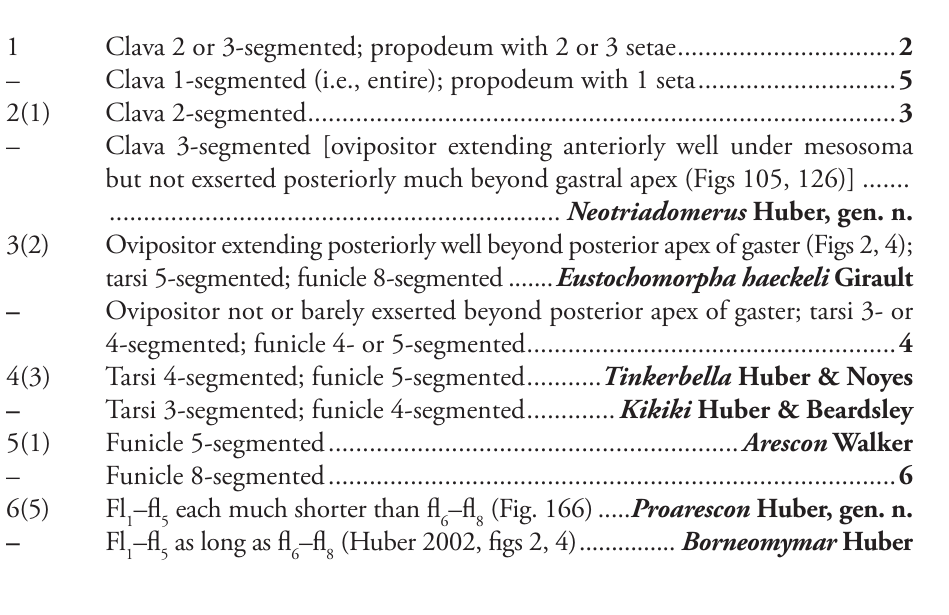
Discussion Huber (2002) treated Triadomerus (extinct) and Eustochomorpha (extant) as sister genera to the remaining extant genera of Mymaridae based, in females (males are unknown), on an 8-segmented funicle and 3- or 2-segmented clava, respectively, i.e., 11 or 10 flagellar seg- ments in total. In Neotriadomerus , males are known and have the same number of flagellar segments as in females, i.e., 11, and this is considered to be as the most plesiomorphic feature possible in Mymaridae. Macalpinia and Triadomerus also have an 8-segmented funicle and 3-segmented clava. Species in all other genera (all extant only, except for one fossil Borneomymar species) whose males are known have a different number of segments between females and males, with at least one less segment in females compared to males. But because males of the species of most extant genera have an 11-segmented flagellum, it is probably safe to assume that males in the extinct genera also have an 11-segmented flagellum, as in females. On this basis, Triadomerus , Macalpinia and Neotriadomerus are treated as the sister clade to other genera within Triadomerini and to all remaining genera of Mymaridae, both extinct and extant. At present the relationships among these three genera cannot be determined but, among extant genera only, Neotriadomerus is clearly the sister genus to the all remaining genera, including Eustochomorpha . Loss of one claval segment in Eustochomorpha , to give a 10-segmented flagellum in its females, makes this the sister genus to the remaining genera of extant Mymaridae other than Neotriadomerus